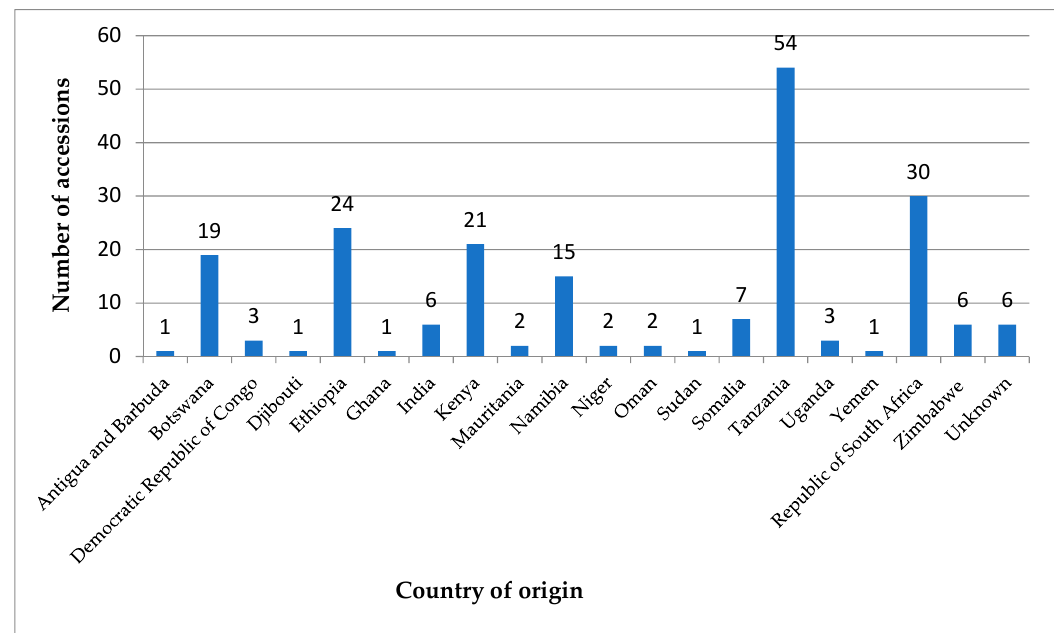
Figure 1. Buffelgrass accessions used in the study by country of origin. Figure 1. Bu ff elgrass accessions used in the study by country of